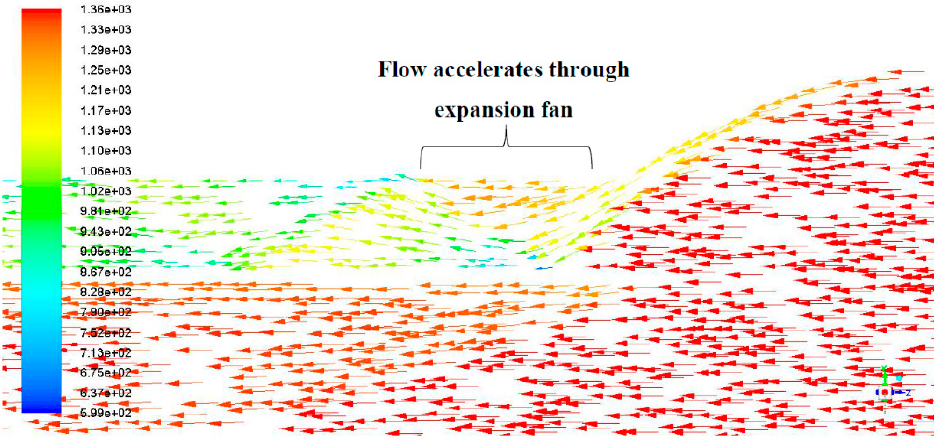
Figure 30. Velocity vectors on the symmetry plane of the 3-D inlet for flight at Mach 4.5.